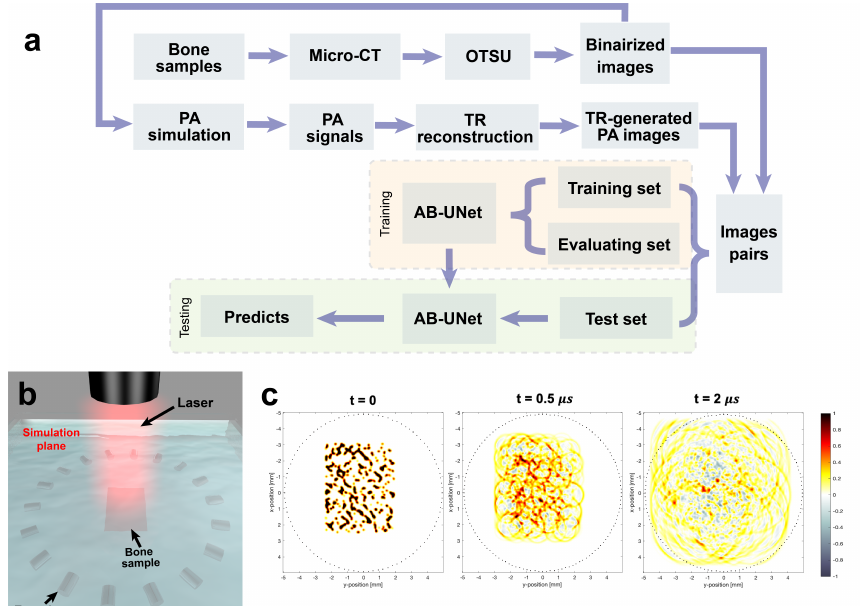
Figure 3. ( a ) The schematic of the data generation process. ( b ) The diagram of the simulation of PA signal propagation. ( c ) k-wave setup and propagation process of photoacoustic (PA) waves from t = 0 to t = 2 µ